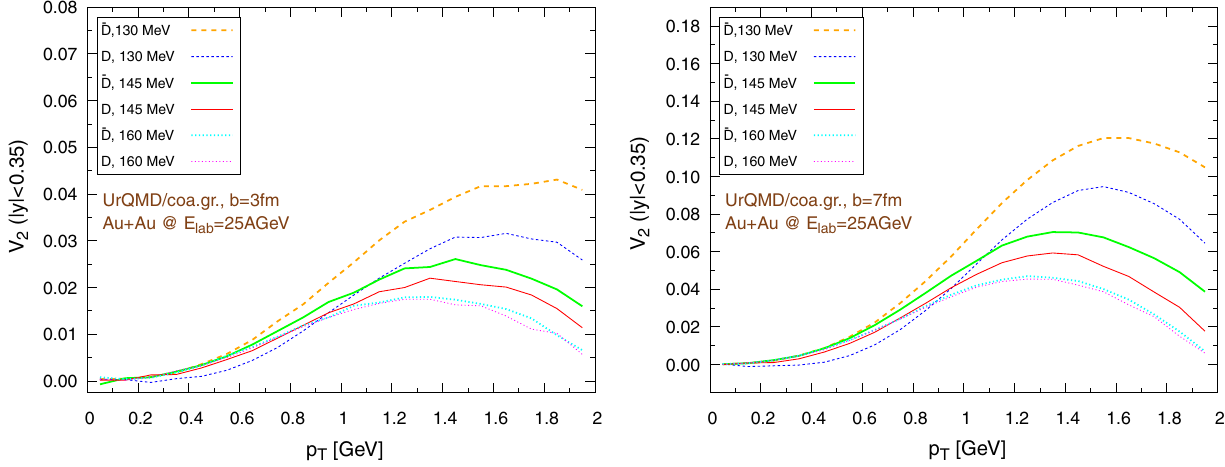
Fig. 19 Elliptic flow of D / ¯ D mesons ( | y | < 0 . 35) within the UrQMD/coarse-graining approach in Au+Au collisions at E lab = 25 AGeV. We show different hadronization temperatures, with fixed parameters: (cid:23) p = 0 . 05 and